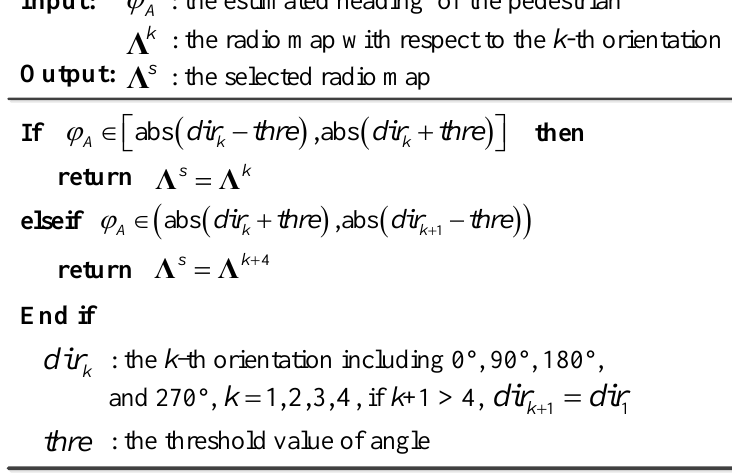
Figure 8. Pseudo code of the selection of the best-matching radio